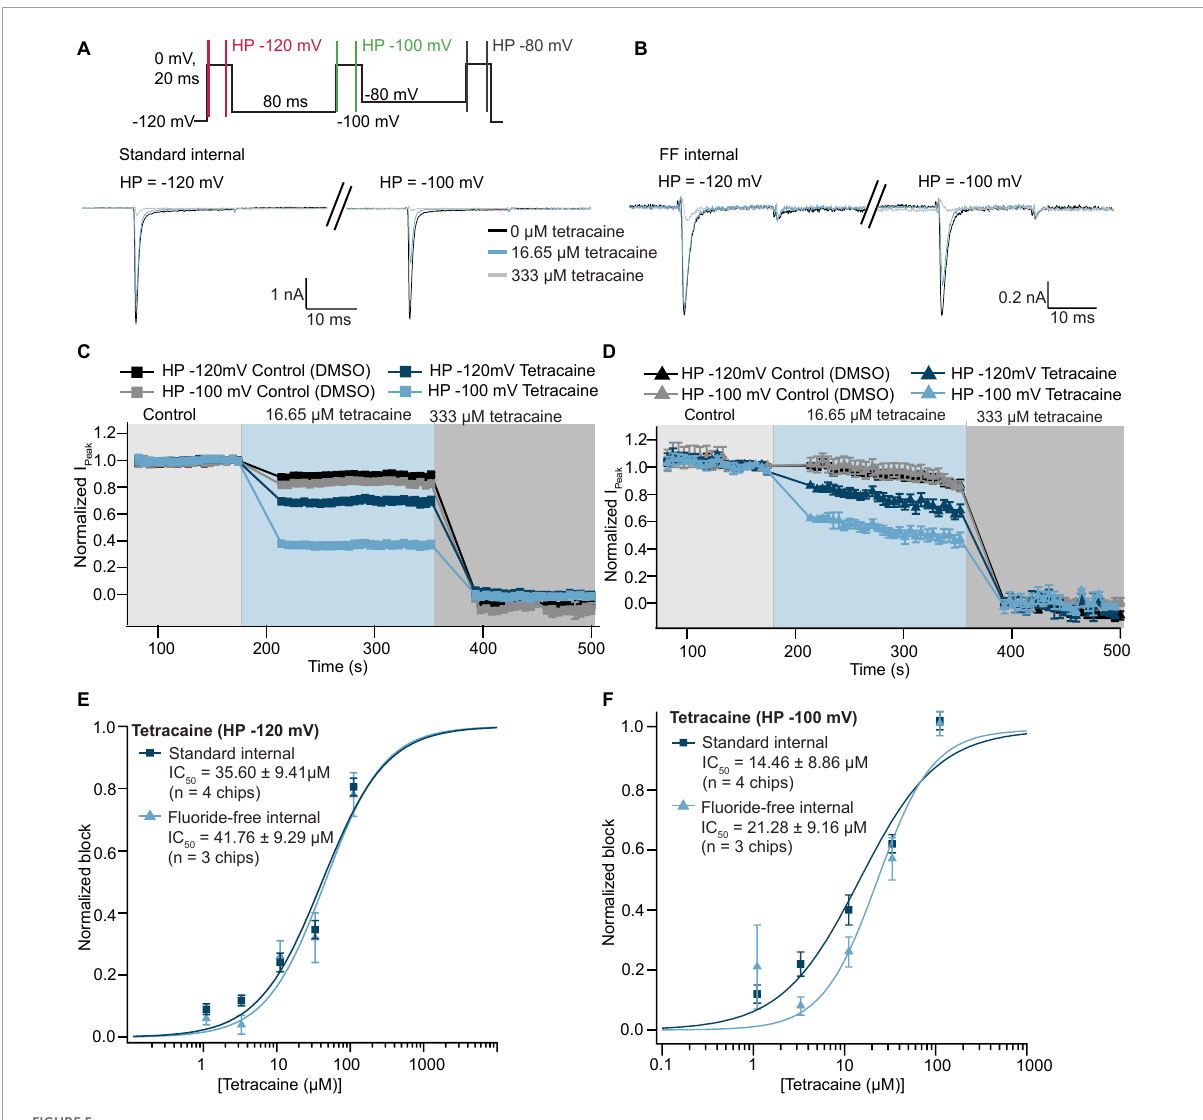
FIGURE5 Pharmacology of Na V 1.5 recorded in standard and fluoride-free internal solution. (A) Raw current traces from an example CHO cell expressing Na V 1.5 recorded in standard internal solution were blocked by tetracaine using a 3-step protocol (voltage protocol shown at the top). Traces elicited by the first (holding potential –120 mV) and second (holding potential –100 mV) step are shown. (B) Raw current traces from an example CHO cell expressing Na V 1.5 recorded in fluoride-free internal solution were blocked by tetracaine. (C) Corresponding time course of block by tetracaine in standard internal solution for an average of 23 wells (at different holding potentials), time course in DMSO for an average of 41 wells is also shown. (D) Corresponding time course of block by tetracaine in fluoride-free internal solution for an average of 10 wells (at different holding potentials), time course in DMSO for an average of 35 wells is also shown. (E) Concentration response curves for tetracaine in standard internal solution or fluoride-free solution at a holding potential of –120 mV are shown overlaid. (F) Concentration response curves for tetracaine in standard internal solution or fluoride-free solution at a holding potential of –100 mV are shown